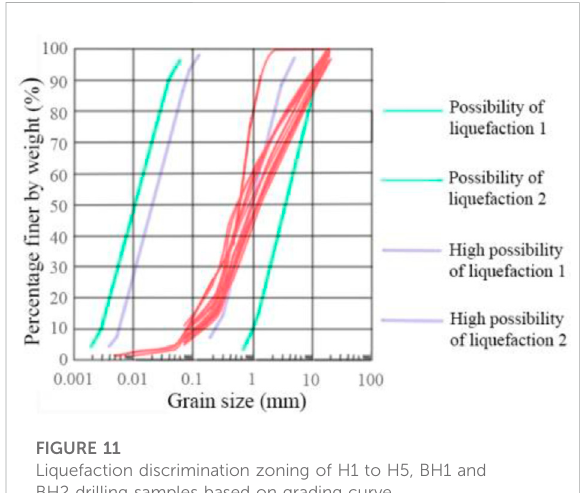
FIGURE 11 Liquefaction discrimination zoning of H1 to H5, BH1 and BH2 drilling samples based on grading